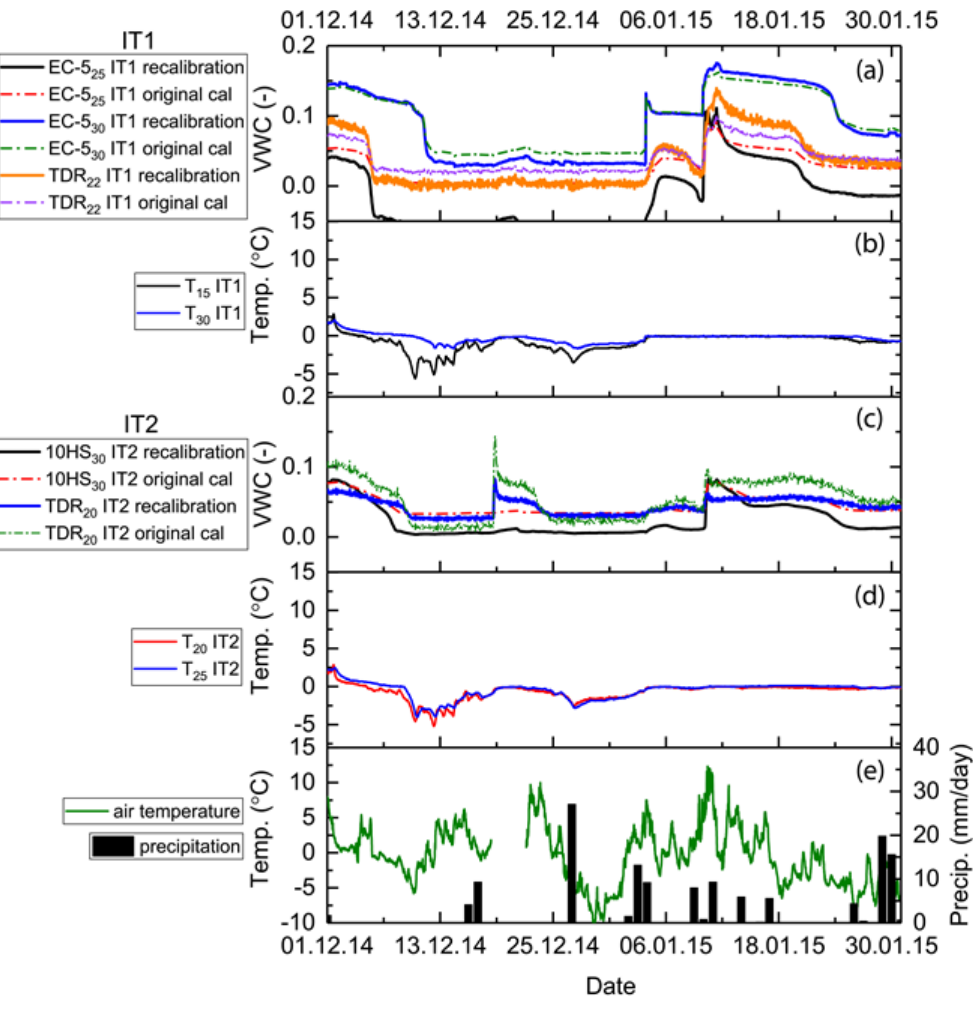
Figure 15. Data Period 2: 1 December 2014–30 January 2015. Site-specific calibration: comparison between data based on original calibration and the recalibration for the winter period.